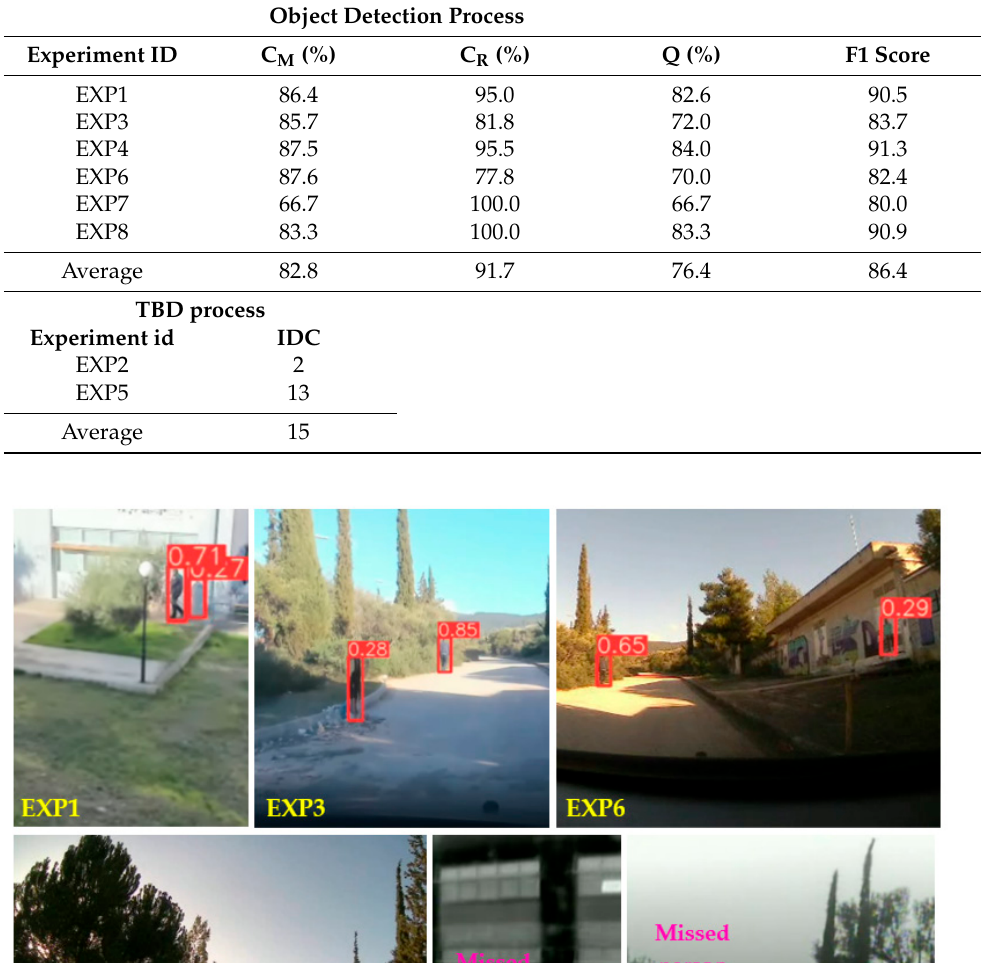
Table 4. Quantitative object detection and TBD results per experiment for representative videos frames.